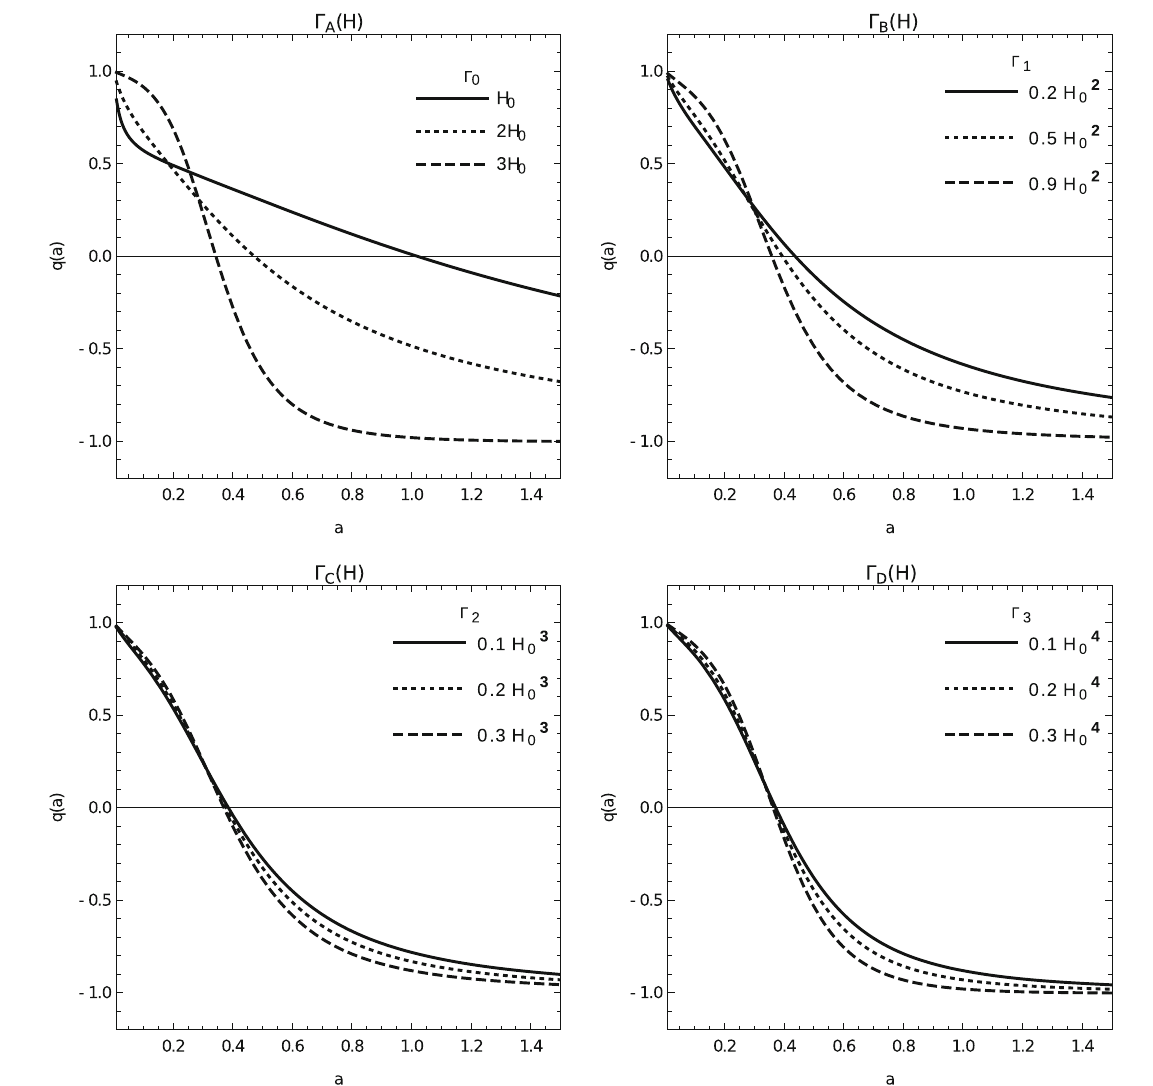
Fig. 1 Qualitative evolution of the deceleration parameter q ( a ) given by the numerical solutions of Eq. (9 ) for various particle creation mod- els as given by the expression (11). The upper left panel stands for (cid:2) ( H ) = (cid:2) (cid:2) = H A 0 where 0 0 (solid curve), 2 H 0 (dashed curve) and 3 H 0 (longdashed curve). The upper right panel for (cid:2) B ( H ) = 2 H 0 + (cid:2) 1 H − 1 with (cid:2) 1 = 0 . 2 H 2 (solid curve), 0 . 5 H 2 0 0 . 9 H 2 (longdashed curve). The lower left panel stands for (cid:2) C ( H ) = 0